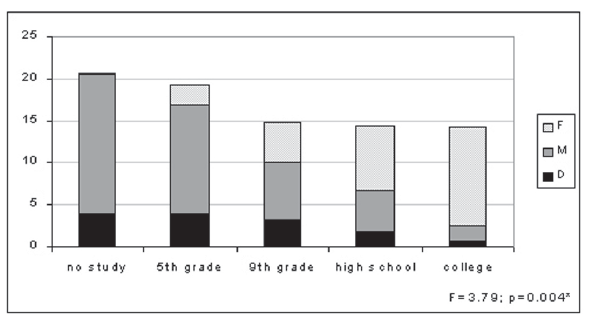
FIGURE 5- Prevalence of dental caries (DMFT and standard deviation) according to self-reported dental treatment needs. Bauru, Brazil,